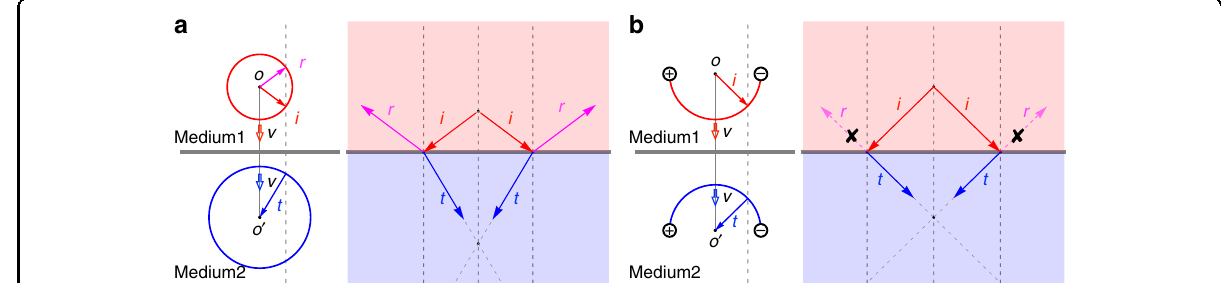
Fig. 1 Illustrations of negative refraction of different mechanisms. a Negative refraction with conventional negative index medium. The left and right panels show the negative refraction in the momentum space and in the real space, respectively. Arrows labeled by i , t , and r represent the wave vectors of incident, refracted, and re fl ected waves respectively. The direction of group velocity v is indicated by the hollow arrows. b All-angle RE fl ectionless Negative refraction (AREN) for surface states at the interface of a minimal ideal Weyl system. EFCs in the con fi guration of open semicircles are illustrated, where the re fl ected wavevector ( r ) is forbidden because the re fl ection state does not exist. Therefore, all energy launched from the source is collected to form the